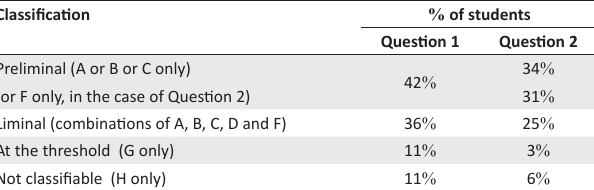
TABLE 3: Classification of responses to Question 1 ( N = 36) and Question 2 ( N = 32).